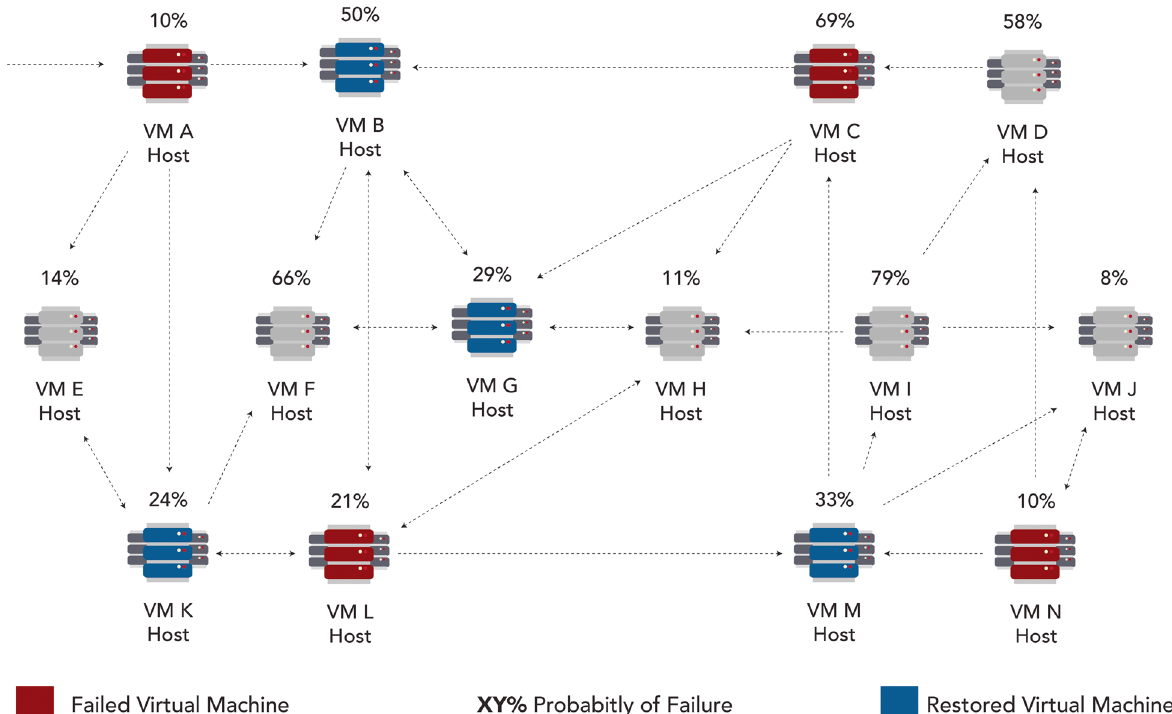
Fig. 9 A representation for the peer‑to‑peer network for achieving reliability, where the failed VMs, restored VMs and failure probability VMs are represented with the colours of red, blue and grey respectively with their rate in